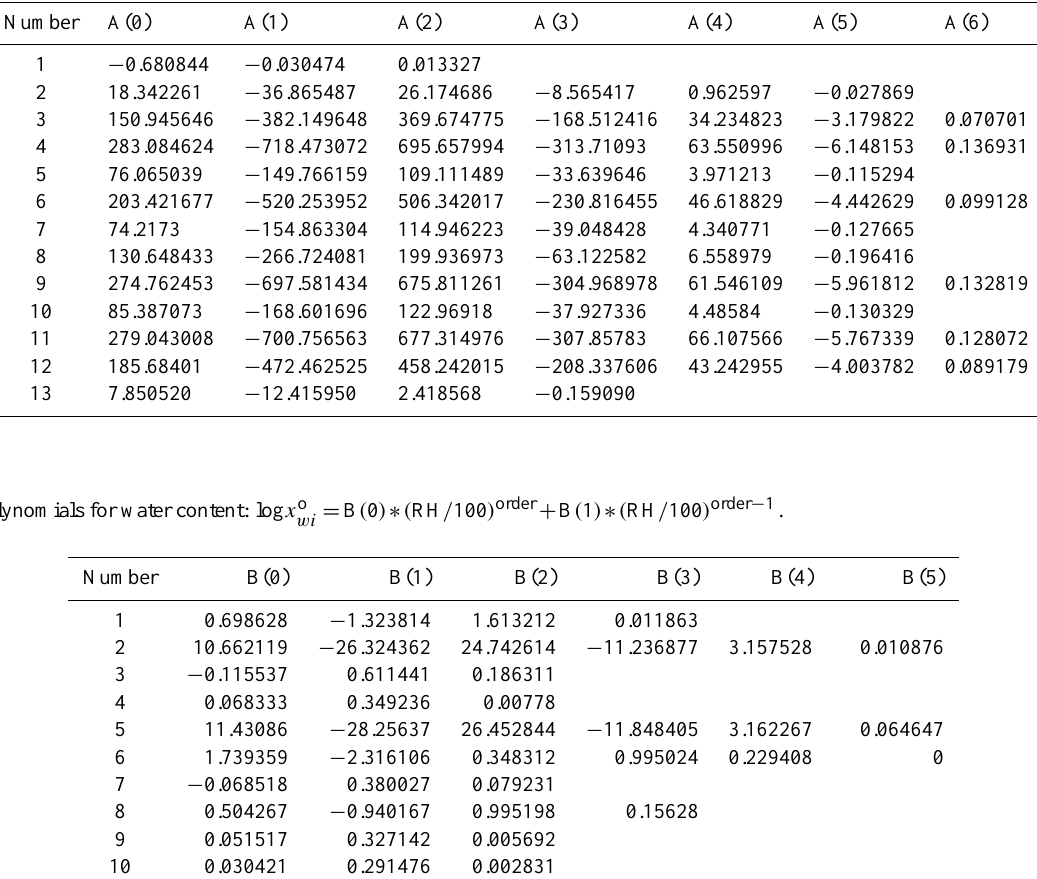
Table 2. Polynomials for binary activity coefficient: ln γ o